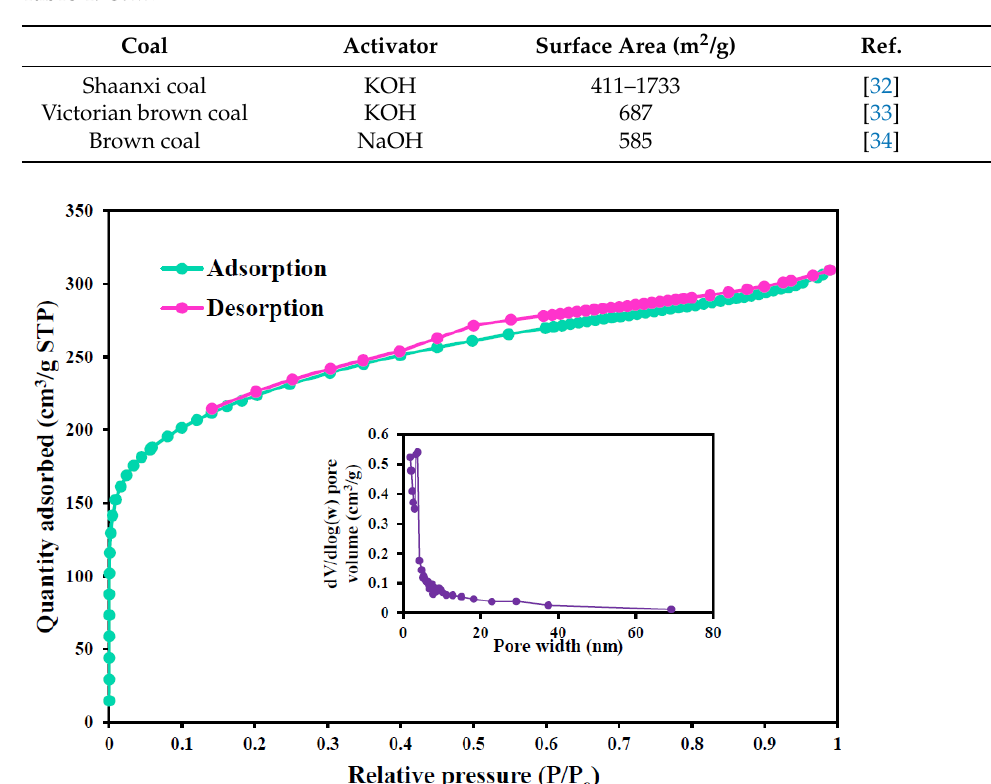
Figure 1. The N 2 adsorption-desorption isotherms and pore size distribution (inset) of MCAC. Table 4. Comparison of the surface area of coal from different